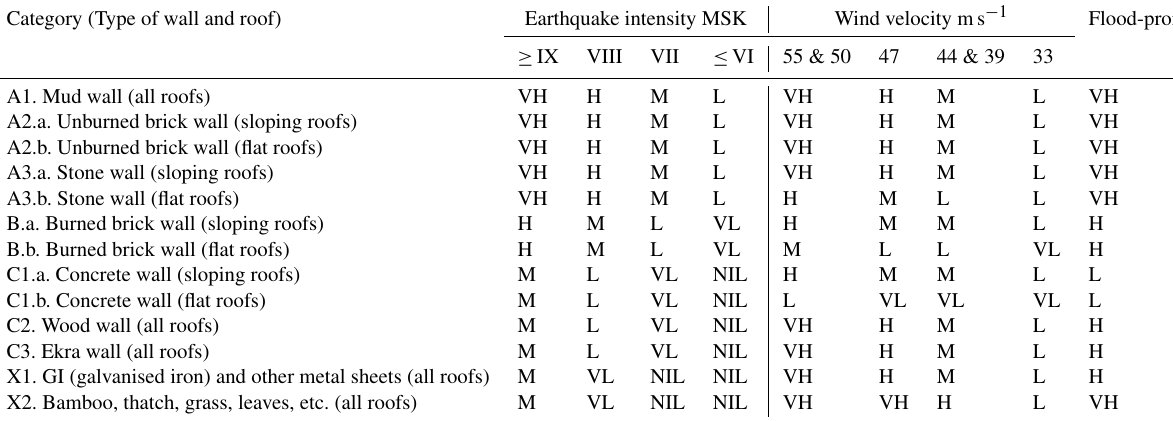
Table 3. Damage risk to various housing categories identified by BMTPC under various hazard intensities (BMTPC, 2019). MSK: Medvedev–Sponheuer–Karnik.